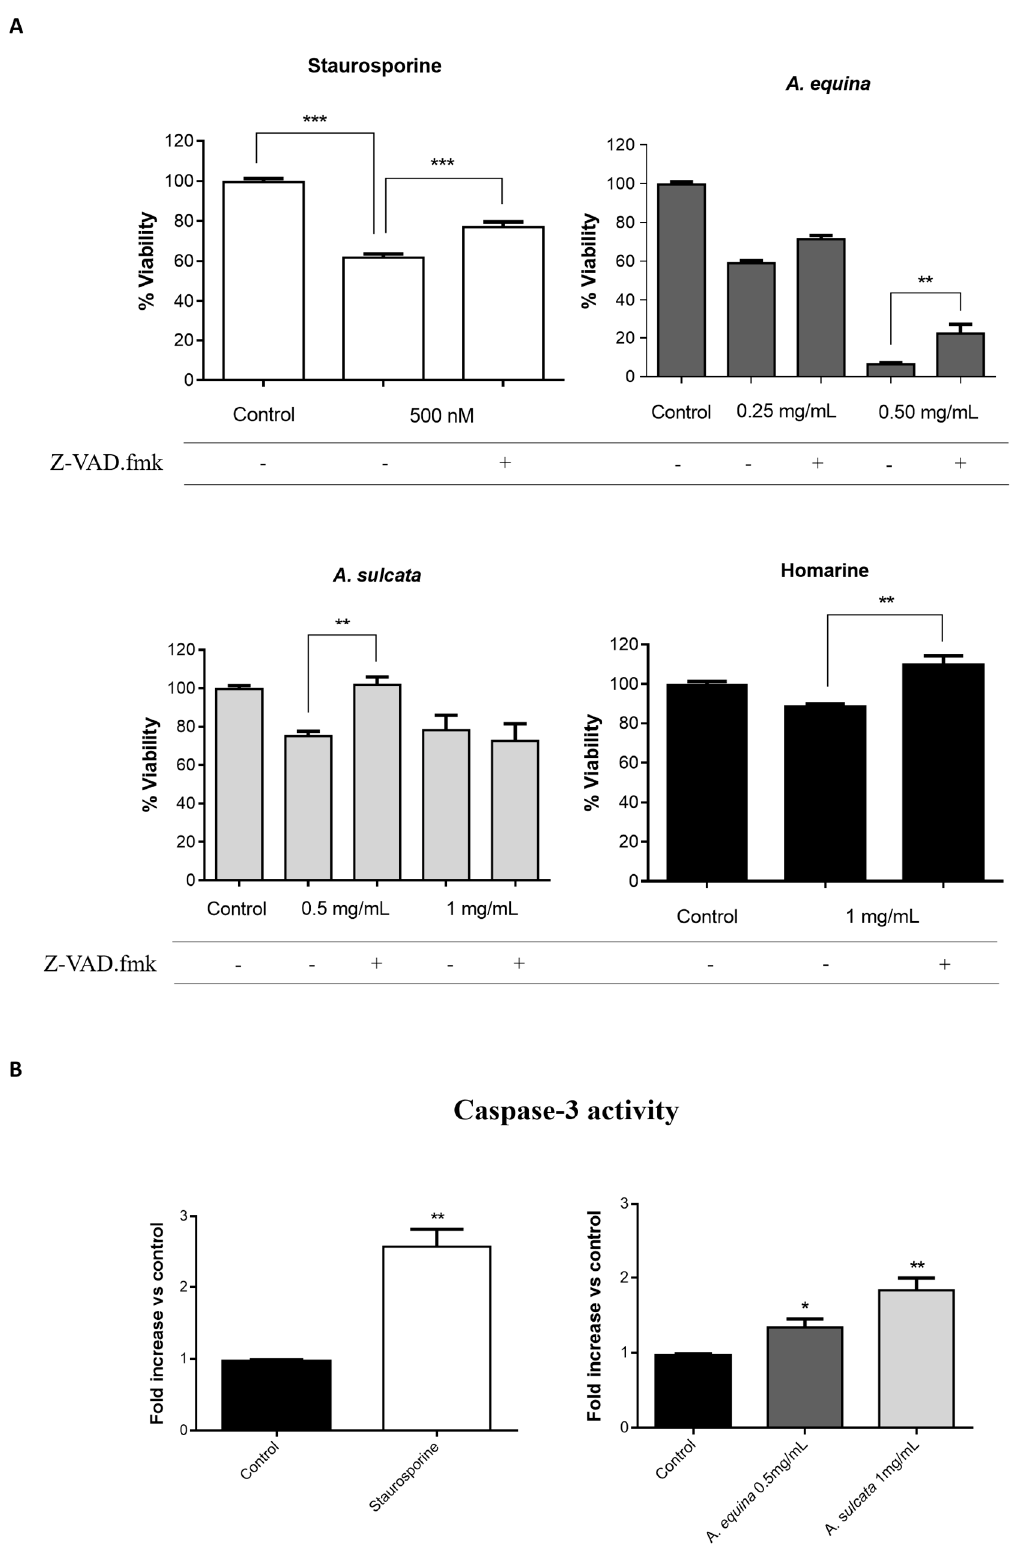
Figure 3. ( A ) Protective effect of the pan-caspase inhibitor Z-VAD.fmk in RAW 264.7 cells treated with aqueous extracts of sea anemones and homarine for 8 h; ( B ) Caspase-3 activity in RAW 264.7 cells treated with the aqueous extracts of A. equina and A. sulcata for 8 h. Staurosporine was used as a positive control for caspase activation and caspase inhibition. Results are presented as mean ± standard error of the mean of four independent experiments performed in triplicates. Statistical significance: * p < 0.05, ** p < 0.01, *** p < 0.001.